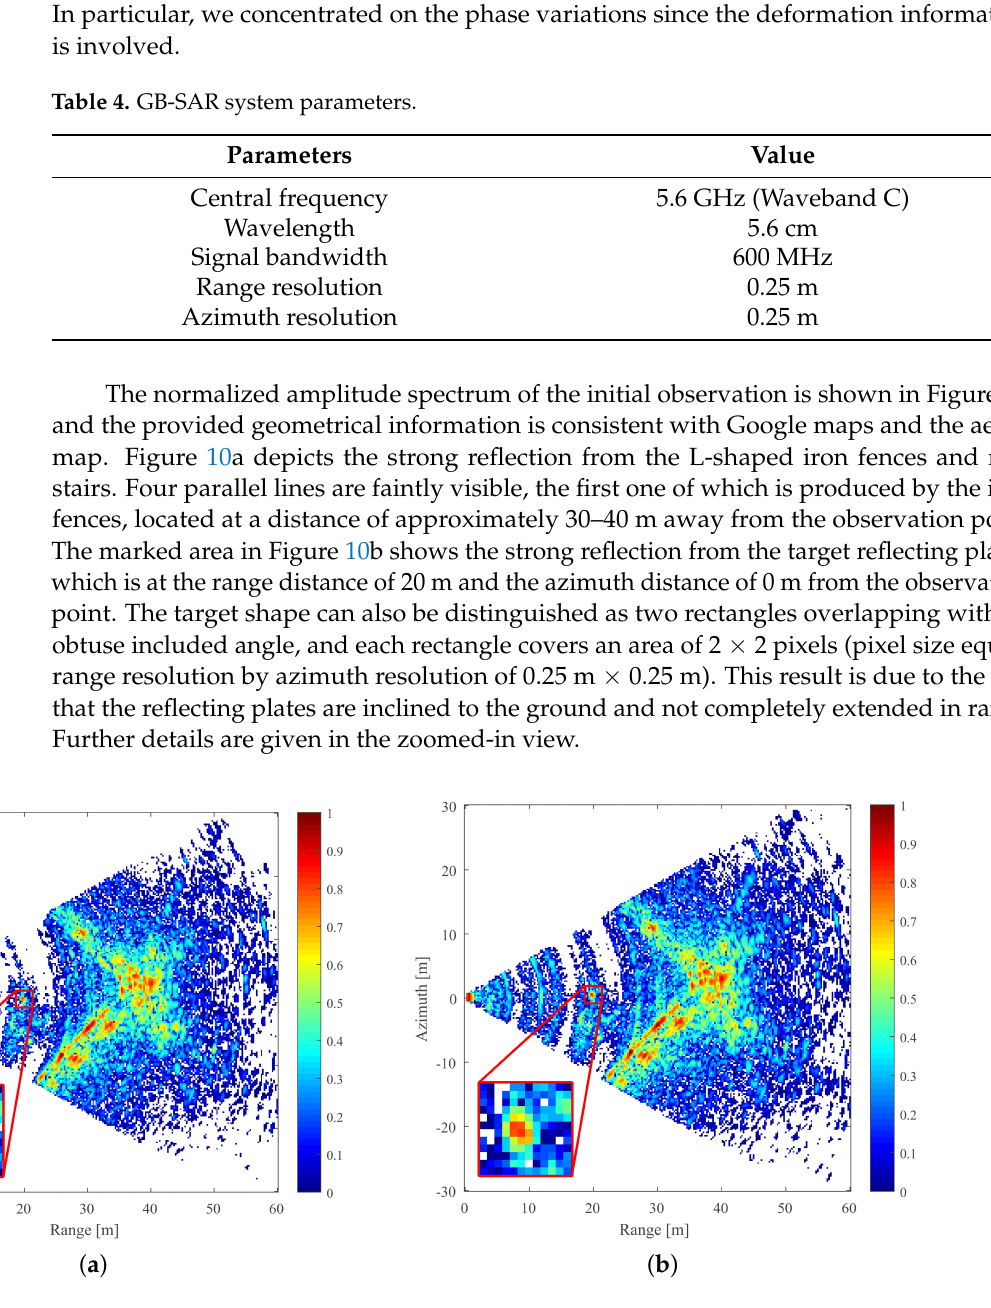
Figure 10. Normalized amplitude spectrum. Observations on 15th April. ( a ) In 17:47, before Deformation I ( b ) In 17:58, after Deformation